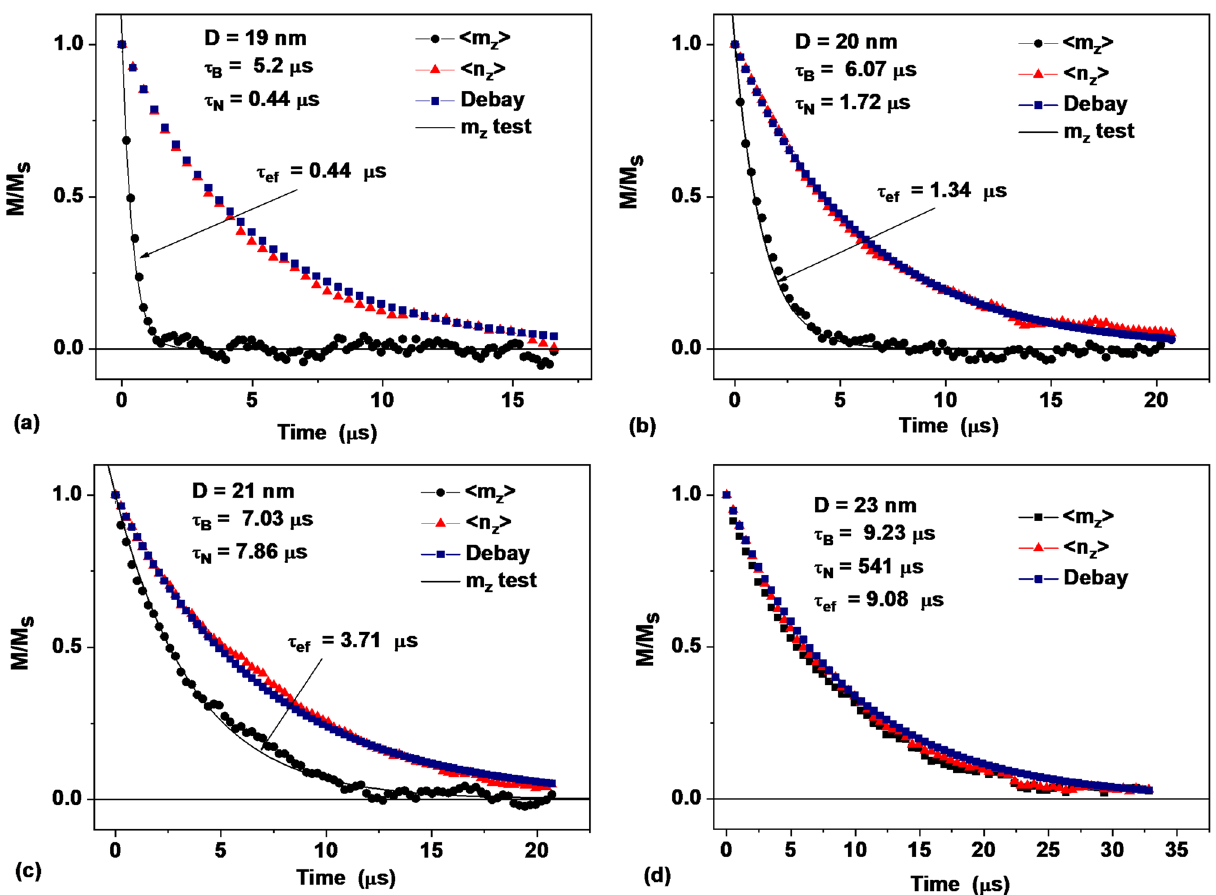
Figure 3. Relaxation curves of dilute assemblies of magnetic nanoparticles in a liquid with viscosity η = 0.02 g/(cm s) at a temperature T = 300 K for particles of different diameters: ( a ) D = 19 nm, ( b ) D = 20 nm, ( c ) D = 21 nm and ( d ) D = 23 nm. Circular and triangular dots show the time dependence of the projections < m z ( t ) > and < n z ( t ) > , respectively. The square dots show the Debye orientation relaxation process for nonmagnetic nanoparticles with the corresponding relaxation time τ B . The solid curves show the exponential approximation of the < m z ( t ) > dependence with the corresponding effective relaxation time τ ef , Eq.